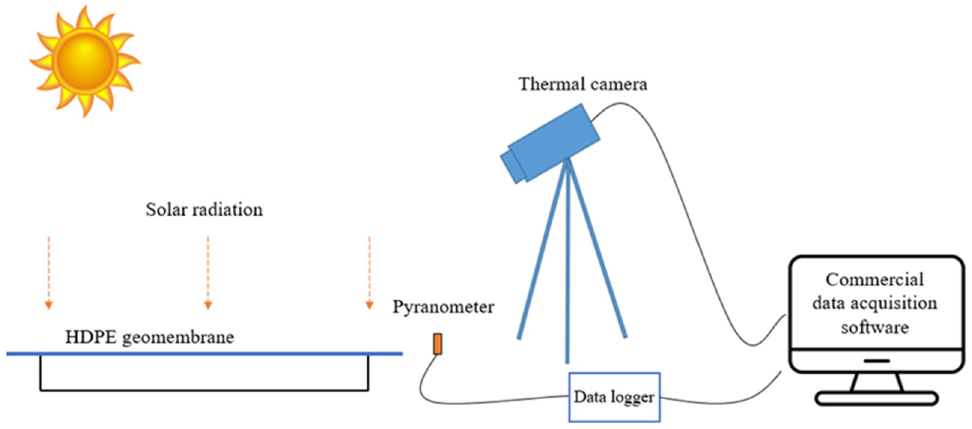
Figure 2. Illustration of data acquisition phase in the quasi-active thermography experiment.